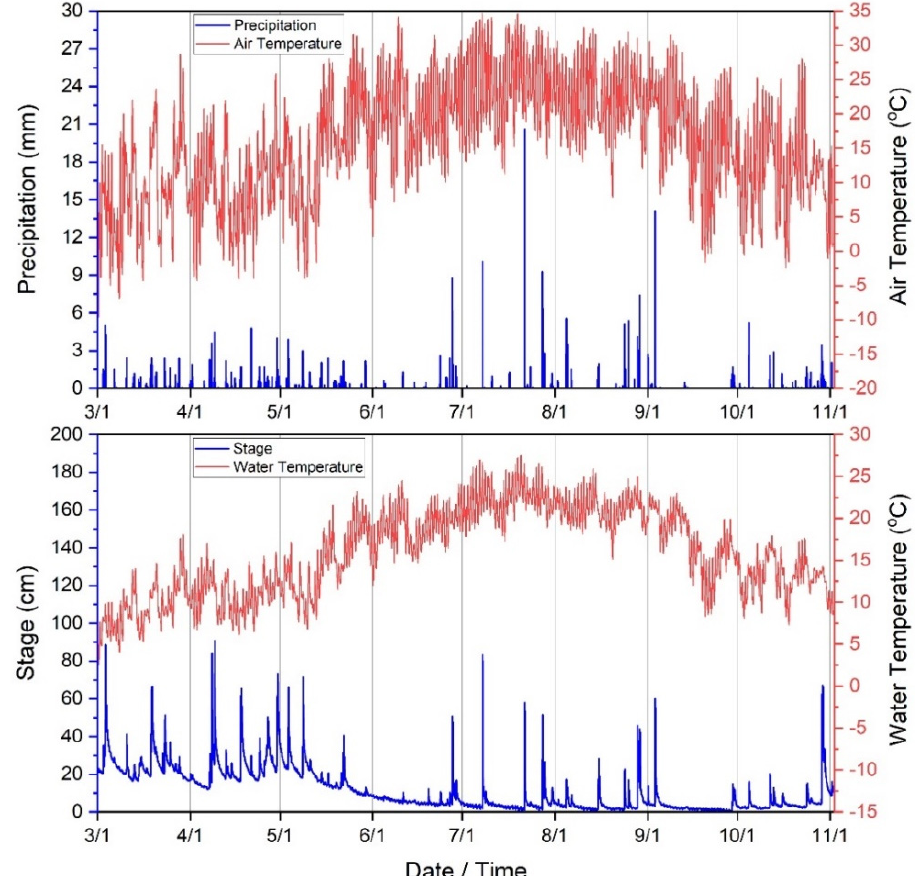
Figure 2. Climate variables (30 − min time series) collected during the current study period (3